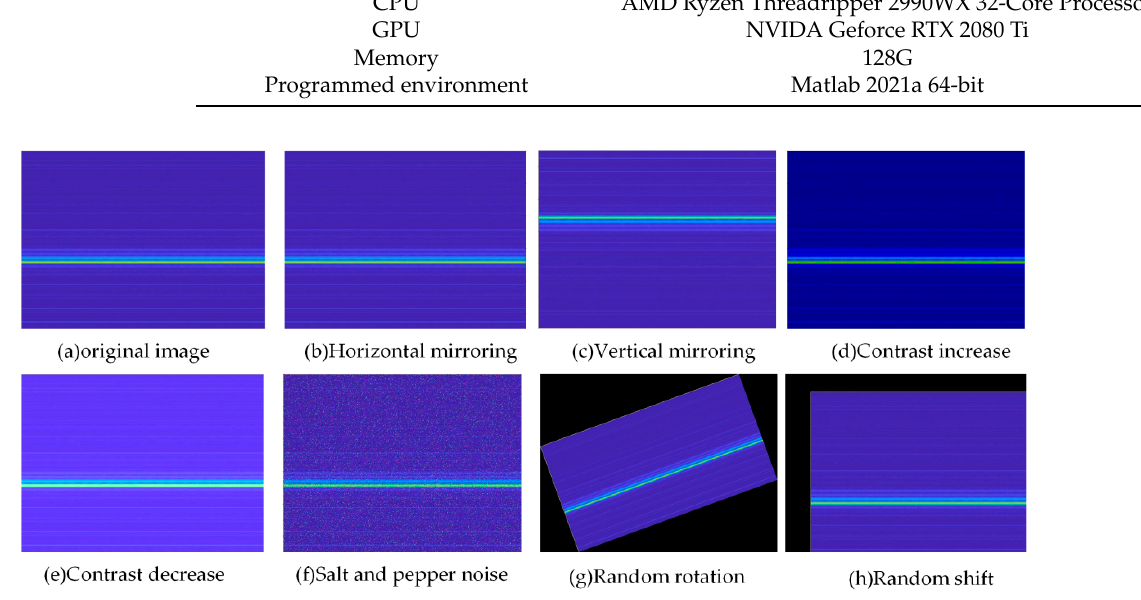
Figure 7. Image augmentation. Table 2. Computer platform and environment